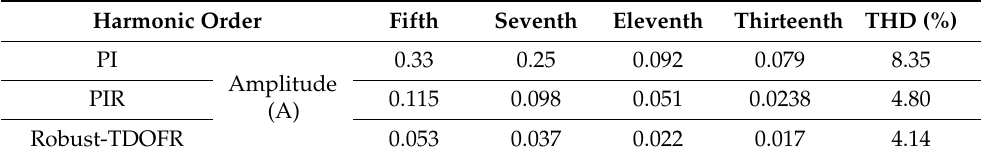
Figure 12. Simulation results of phase current and FFT analysis with load: ( a ) with a PI controller, ( b ) with a PIR controller and ( c ) with a Robust-TDOFR controller. Table 4. Simulation results under the operation of